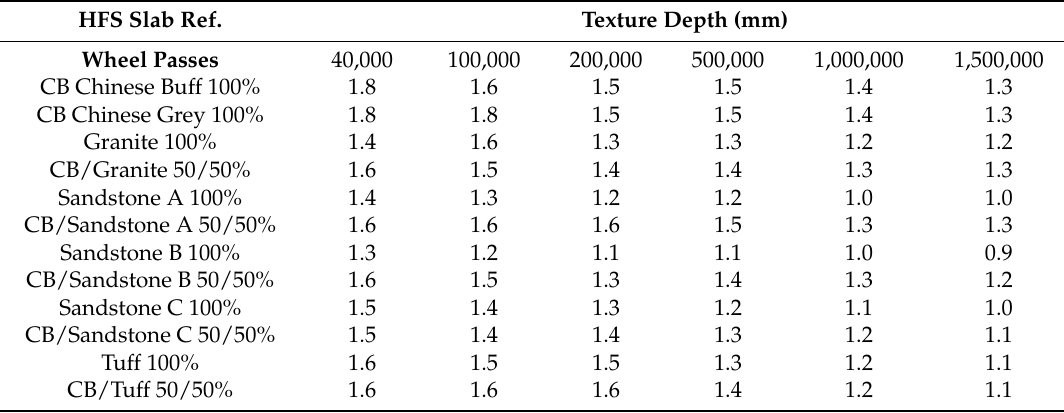
Table 3. Texture depth data up to 1.5 million wheel-passes (Aetec data). HFS Slab